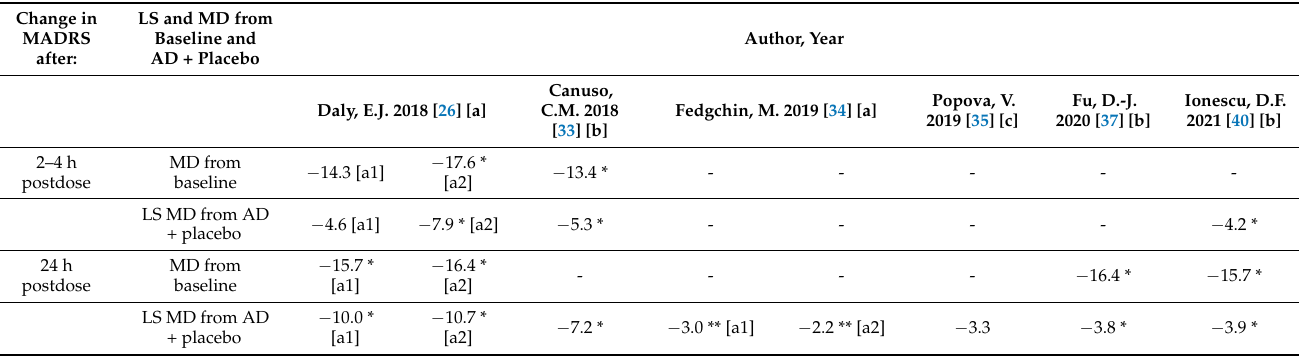
Table 2. Esketamine rapid onset. Change in MADRS score at 2–4 h and 24 h after esketamine